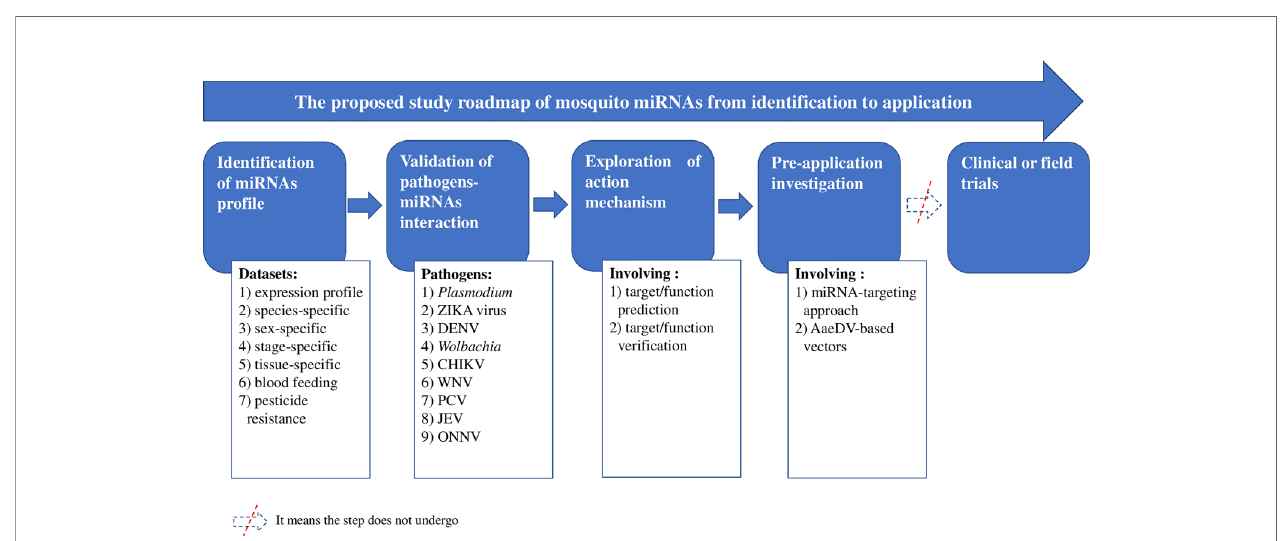
FIGURE 1 | Overall advances in studies of mosquito miRNAs. ZIKA, Zika virus; DENV, Dengue virus; CHIKV, Chikungunya virus; WNV, West Nile virus; ONNV, o ’ nyong ’ nyong virus; JEV, Japanese encephalitis virus; PCV, Palm Creek virus; AaeDVs, Ae. aegypti densoviruses.